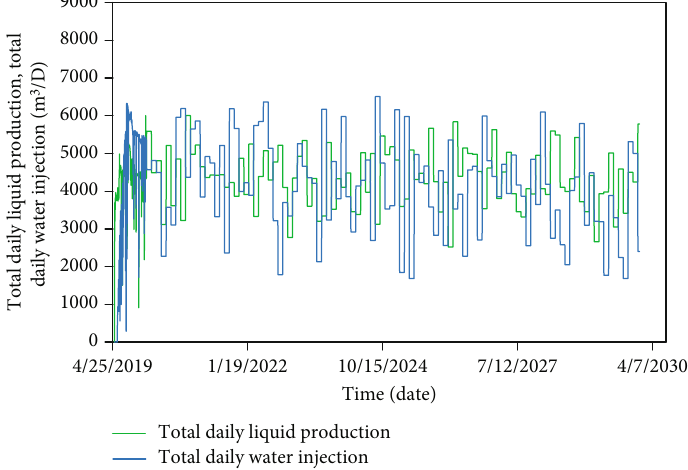
Figure 11: Production system with the optimized plan.